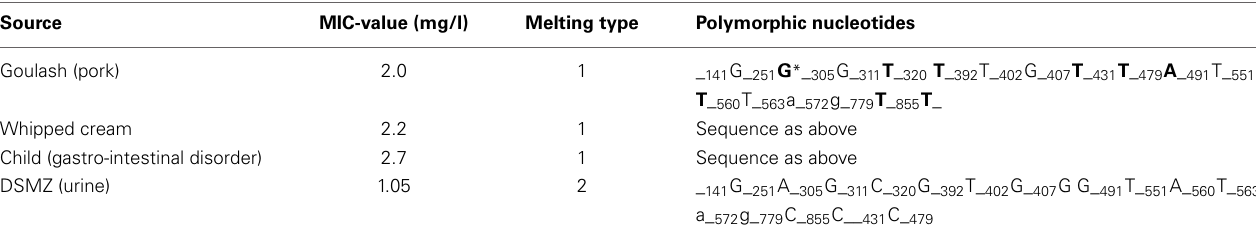
Table 4 | Polymorphism analysis (NCBI BLAST) of eme A-amplicons as sequenced in the present